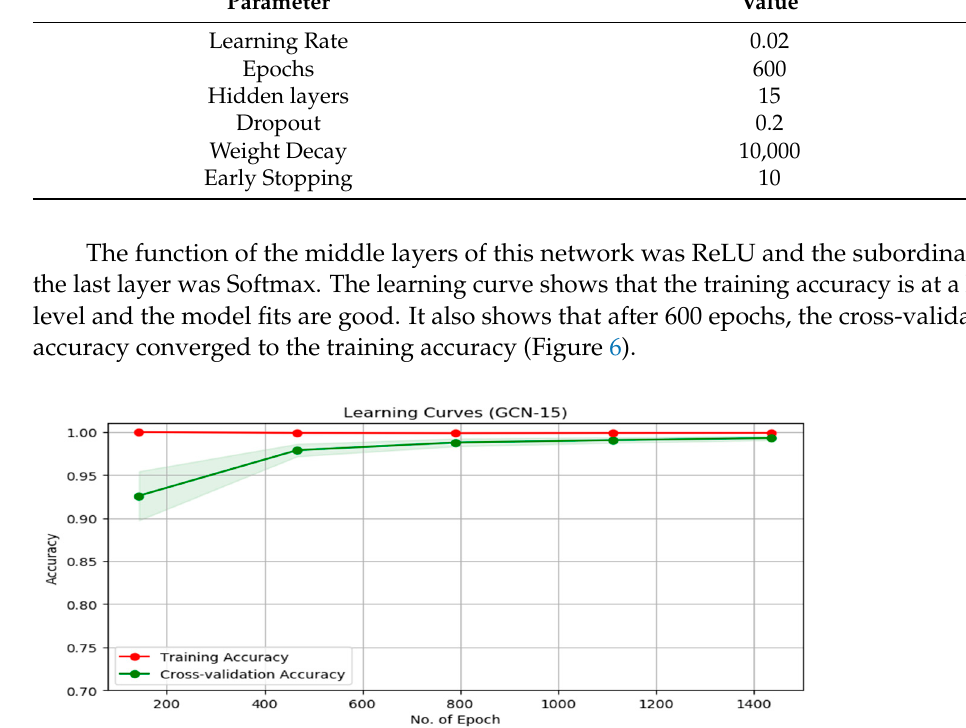
Figure 6. Learning curve for the GCN-MI with 15 layers.